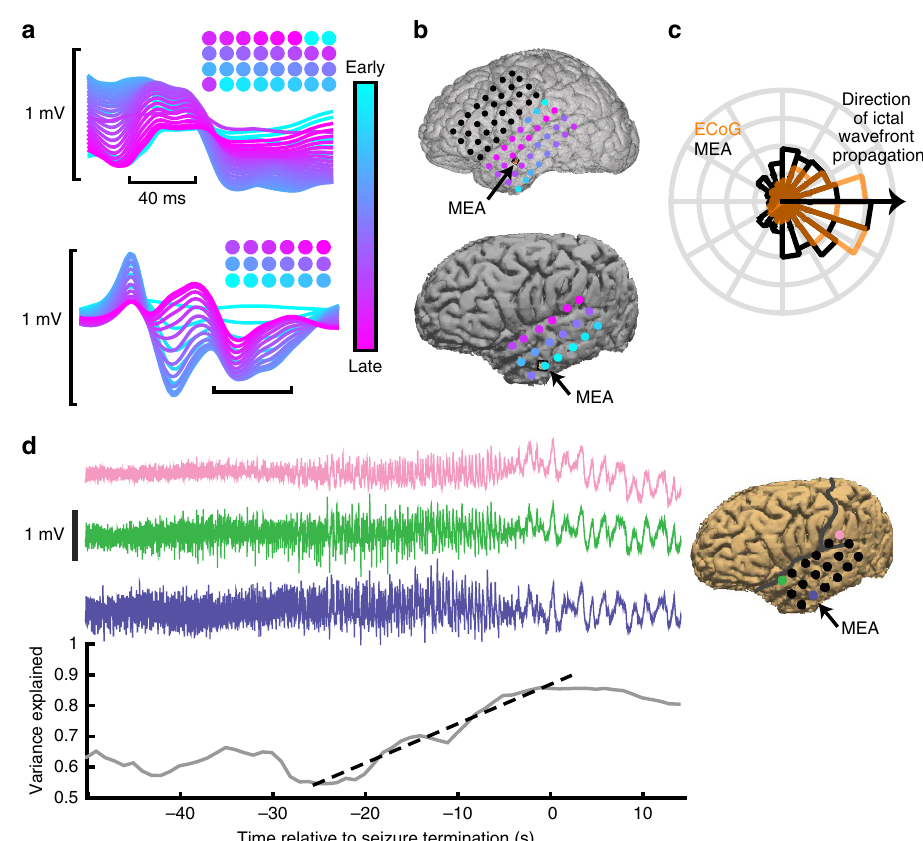
Figure 4 | Travelling waves propagating across the microelectrode array correspond to those propagating across the ECoG grid. ( a ) Examples of ictal discharges recorded across ECoG electrodes in two patients colour coded by when the maximally decreasing slope occurs, with cyan indicating earlier electrodes and magenta later electrodes. Colour-coded circles above the discharges indicate a spatial representation of delays over the ECoG grid, with the same colour code as the voltage traces. ( b ) Reconstructions of ECoG grid and MEA locations for the same patients in a . Average delays across ECoG electrodes are colour coded as in a . Black arrows indicate MEA locations. ( c ) Distributions of MEA pre-recruitment travelling waves (black) and travelling waves ECoG (orange). ( d ) Three channels of LFP recorded from ECoG electrodes during one seizure (patient 3) and a representative increase in variance explained by the first-principal component, across all ECoG electrodes on the grid shown in b (lower), during the pre-termination epoch. The black dotted line shows linear regression used to determine the slope of the variance explained during the pre-termination epoch for the example